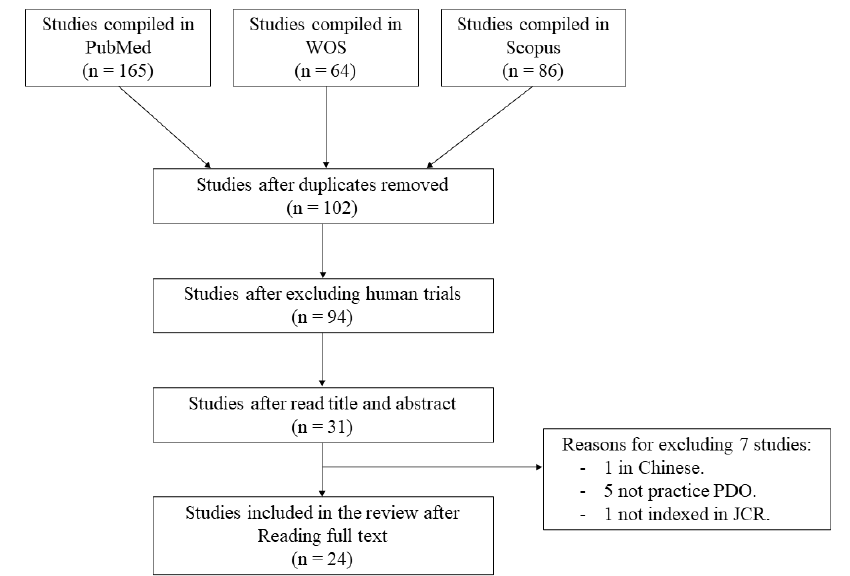
Figure 1. Flow chart of the selected studies.